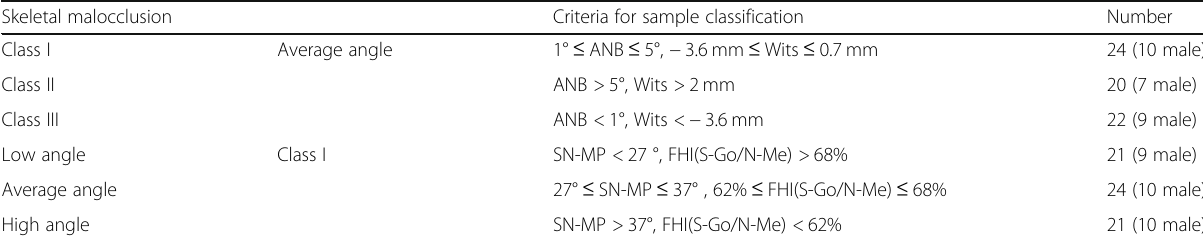
Table 2 The distribution of samples Skeletal malocclusion Criteria for sample classification